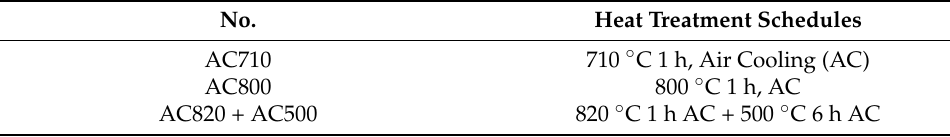
Table 2. Heat treatment schedules of the forged SP700 and SP700Cr alloys.